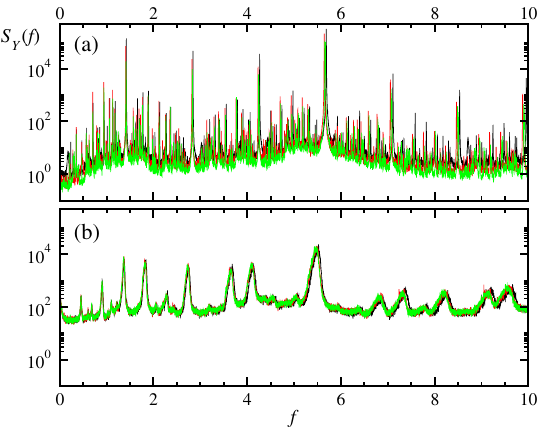
FIG. 6. Power spectra of Y for g ¼ 0 . 8 (a) and 1.3 (b) in each case for N ¼ 4000 (black), N ¼ 16000 (red), and N ¼ 64000 (green). The spectra are obtained by transforming time series of 819.175 time units, sampled every 0.025 units and averaged over 50 different